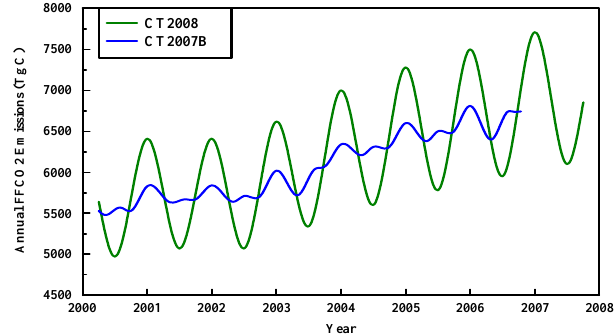
Fig. 7a. Annual FFCO2 emissions for years 1950 to 2007 with the 95% uncertainty shaded. The shaded area is growing with time because the total magnitude of emissions is growing with time and a growing percentage of emissions are coming from countries with less certainty about their emissions. FFCO2 data from Boden et al. (2010) and uncertainty estimates from Andres (unpublished data).